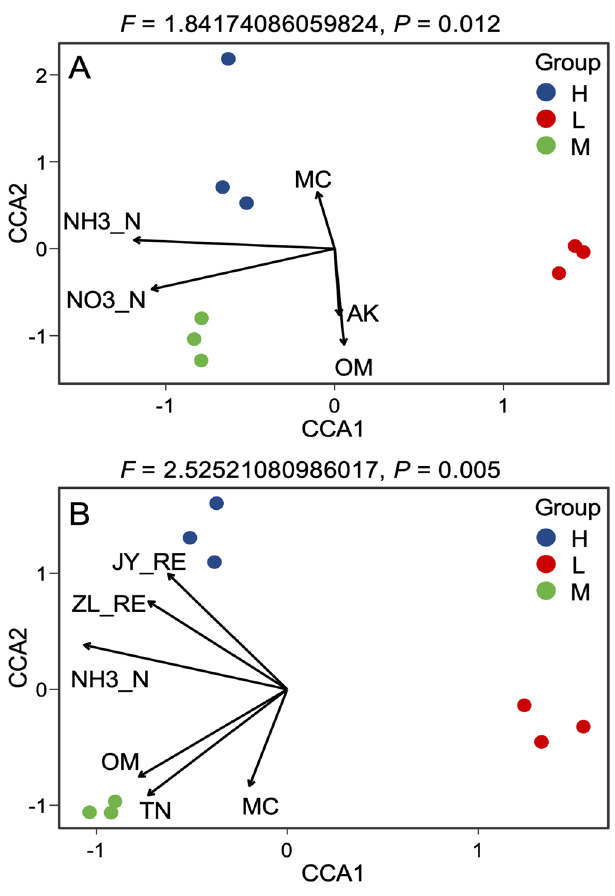
Figure 9. Canonical Correspondence Analysis (CCA) of rice bacterial community.